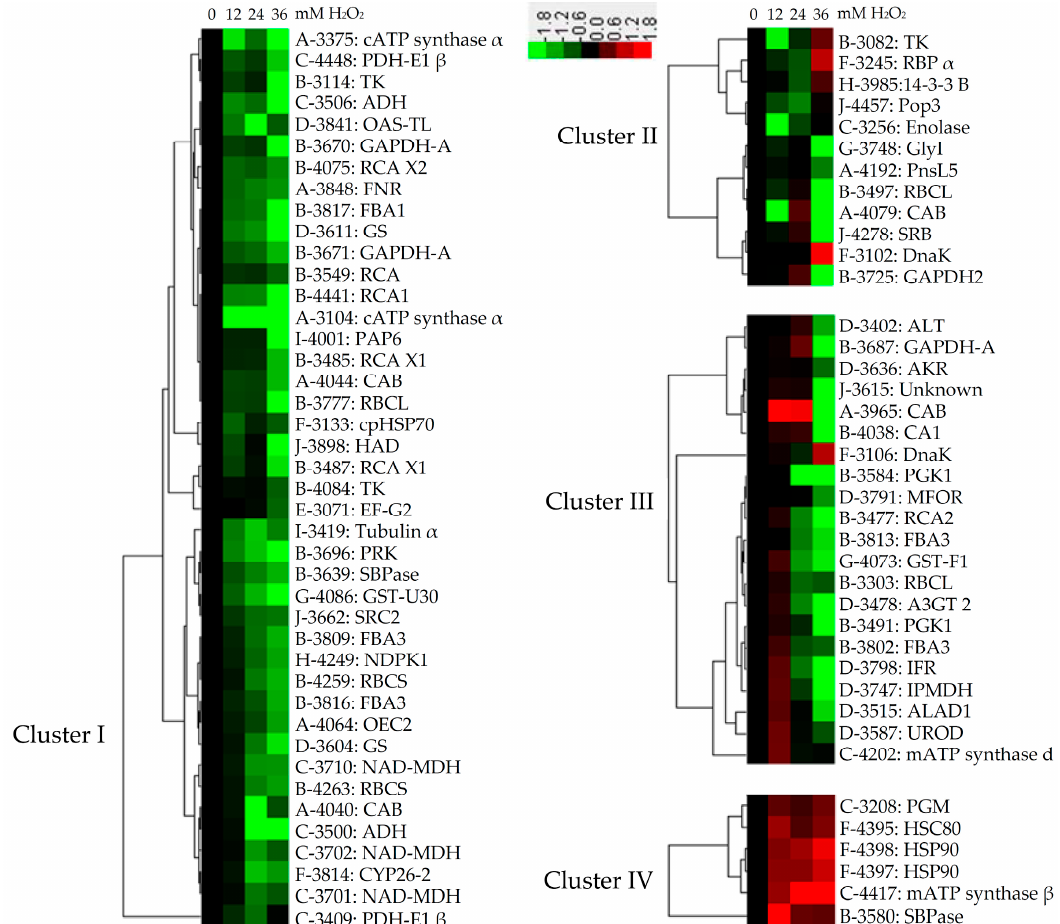
Figure 7. Hierarchical clustering analysis of 81 H 2 O 2 -responsive proteins in leaves of Populus simonii × Populus nigra . The four columns represent different treatments, including 0, 12, 24 and 36 mM H 2 O 2 . The rows represent individual proteins. The increased or decreased proteins are indicated in red or green, respectively. The color intensity increases with increasing abundant differences, as shown in the scale bar. The scale bar indicates log (base2) transformed protein abundance ratios ranging from − 1.8 to 1.8. Functional categories indicated by capital letters, spot numbers, and protein names are listed on the right side. A, photosynthetic electron transfer chain; B, Calvin cycle; C, carbohydrate and energy metabolism; D, other metabolisms; E, protein synthesis; F, protein folding and unfolding; G, redox homeostasis and stress defense; H, signaling; I, cell structure; J, miscellaneous or function unknown. The abbreviations refer to Table 1.